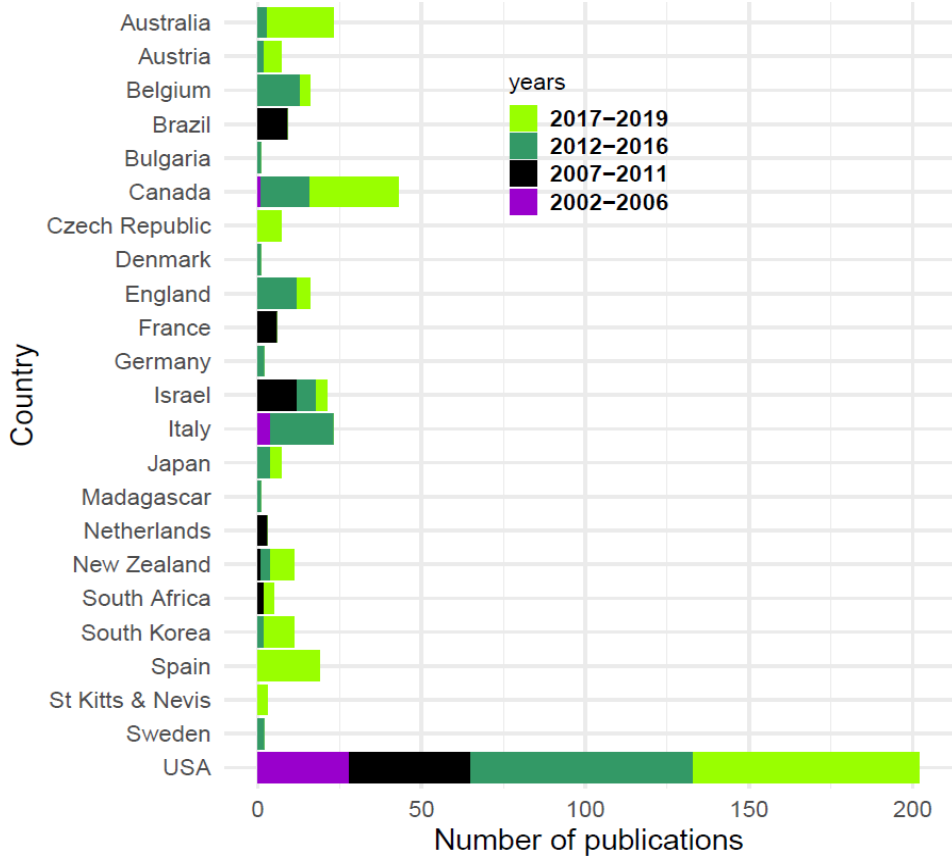
Figure 5. Country of origin of authors publishing TNR papers 2002 – 2019. Table 1. Affiliations of authors publishing TNR papers, 2002 – 2019.